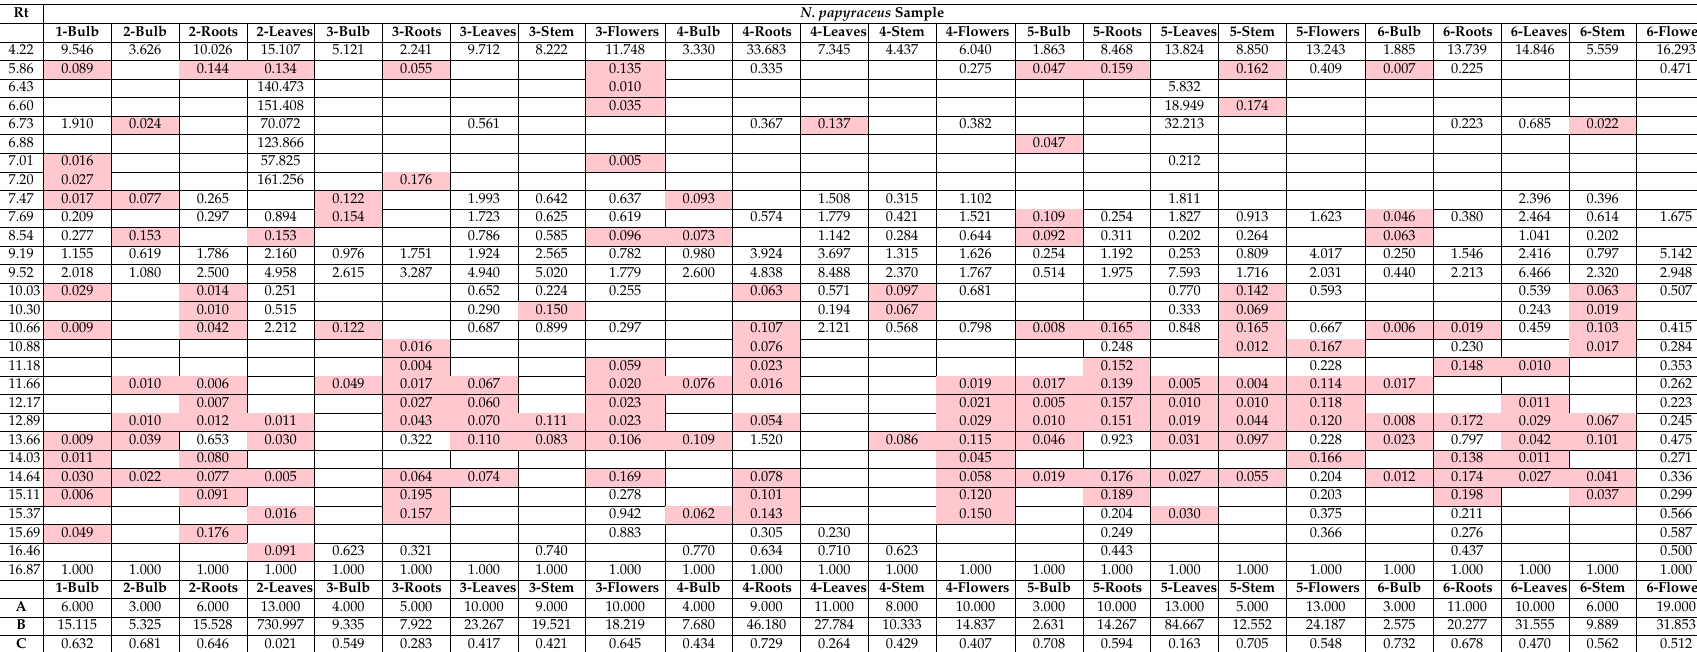
Table A4. Normalized absorbance values of 28 heterocyclic compounds of interest obtained by HPLC-PDA analysis of 24 N. papyraceus alkaloid extract samples. The compounds are listed in order of their retention time (Rt) in minutes. For each sample, all absorbance values were normalized to that of the internal standard papaverine (Rt = 16.87 min). Cells containing values below 0.20 were not considered. An empty cell indicates that the compound was not detected in that plant sample. The compound with an Rt of 4.22 min (“compound 4.22”) was determined to be lycorine based on our results. Row A indicates the total number of compounds in each sample. Row B indicates the total concentration of compounds in each sample. Row C indicates the relative concentration of lycorine, i.e., the fraction of the concentration of compound 4.22 out of the total concentration of compounds (row B), in each